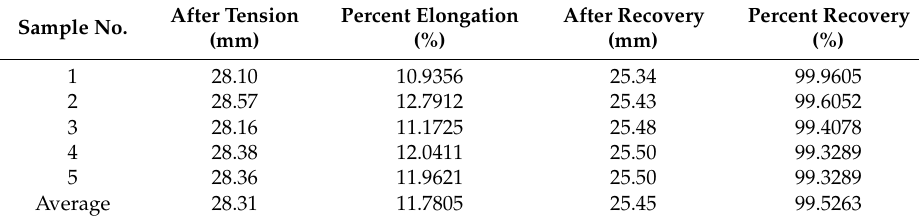
Table A6. DM8530.